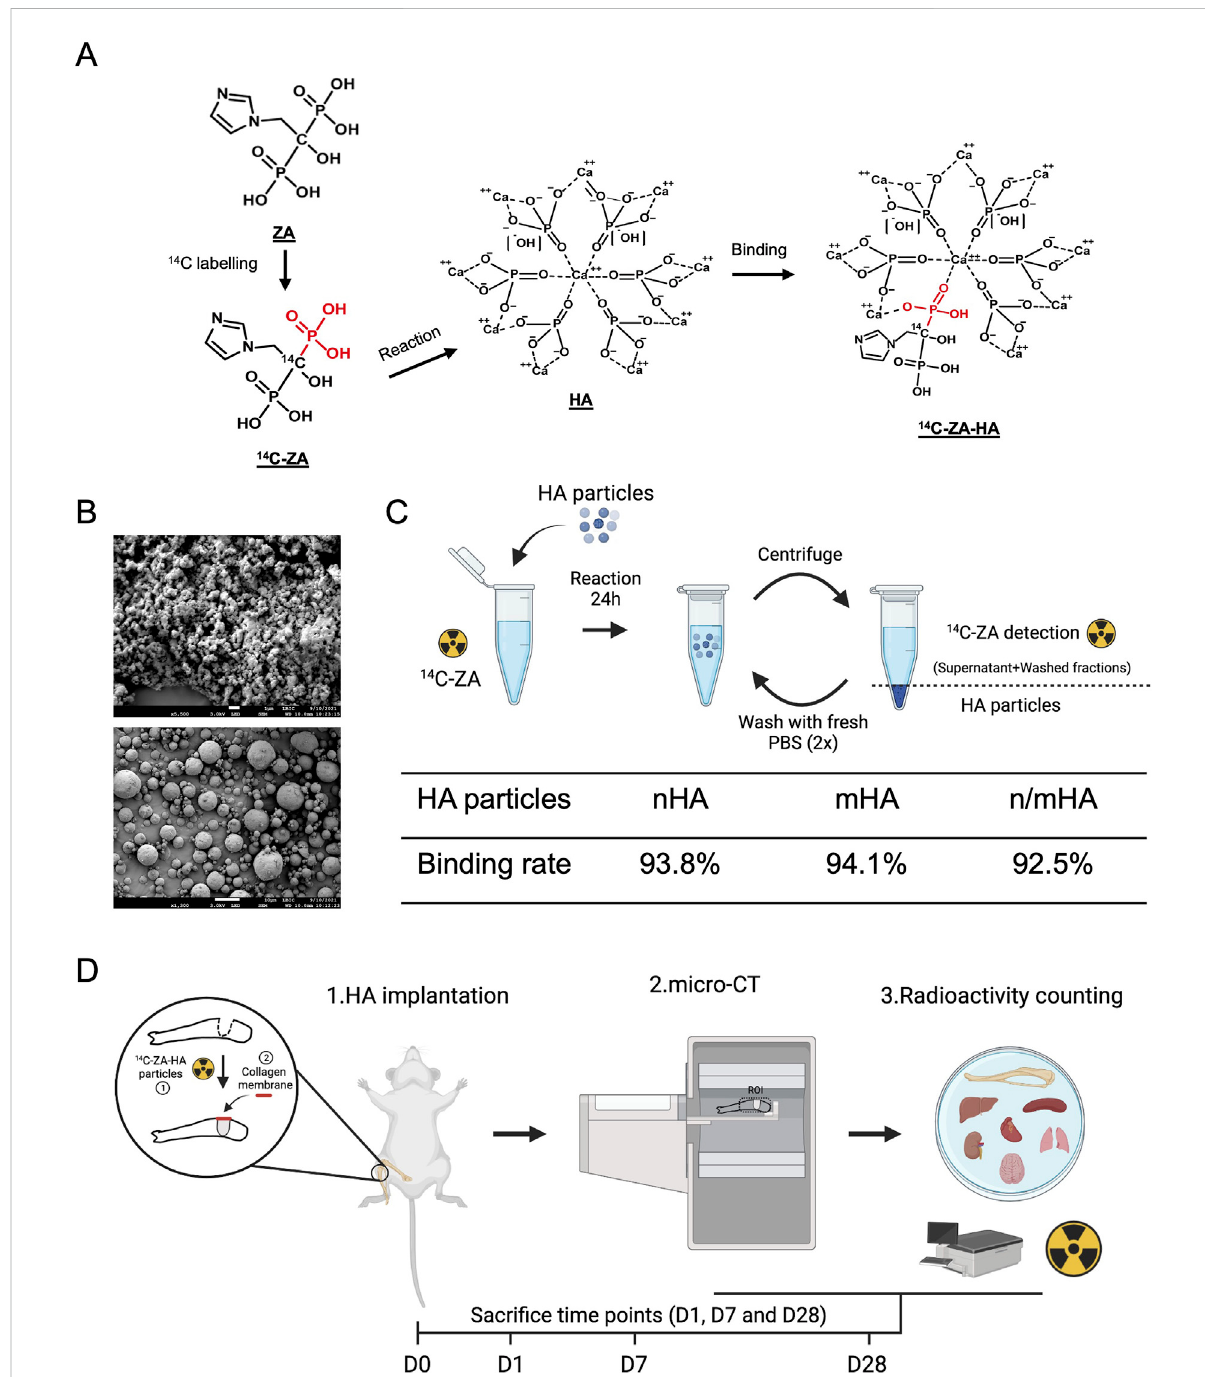
FIGURE 1 Hydroxyapatite particle characterization, labelling and thestudy design. (A) Showsthe speculated mechanism of 14 C-ZA and HAbinding, which makes the evaluation of in vivo HA biodistribution possible. (B) Shows the shape and size distribution of nano- and micro-sized HA particles used in this study. (C) Schematic showing the process of 14 C labelling for nHA, mHA and n/mHA and its binding rate. Panel C was made on BioRender.com. (D) Shows a schematic diagram of the timeline and the evaluation techniques used in the evaluation of in vivo HA particles biodistribution. Brie fl y, the HA particles (nHA, mHA and n/mHA) were fabricated into uniform pellets, which were implanted in the tibia defect and covered by a collagenmembrane.Ateachtimepoint(D1,D7andD28),thetibiawasscannedbymicro-CTtodetectthelocaldistributionofimplantedHAparticles and collected samples (proximal tibia and vital organs) were further analyzed for the detection of radioactivity which indirectly indicated the biodistribution of 14 C-ZA labelled HA particles. This fi gure was made on